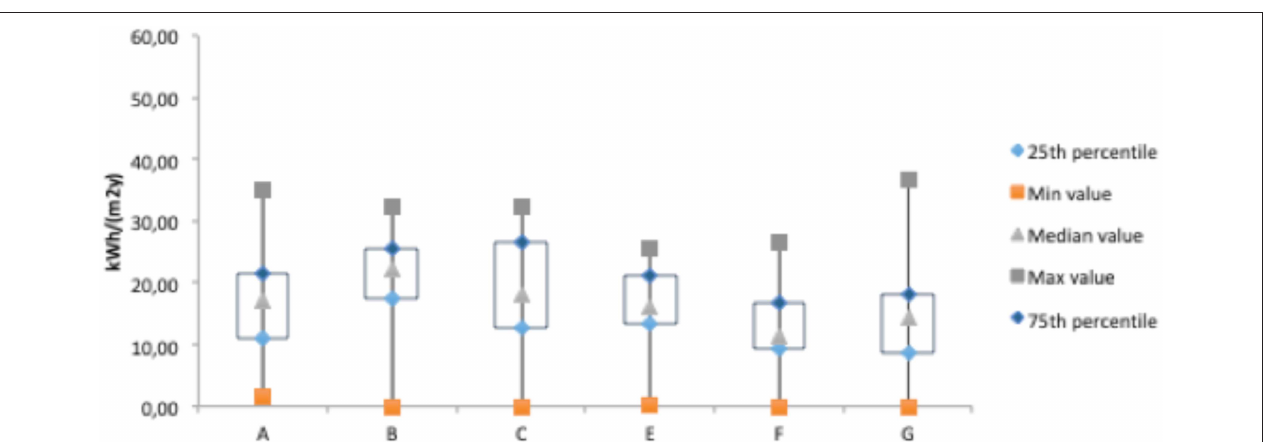
FIGURE 7 | Actual thermal energy consumption for cooling